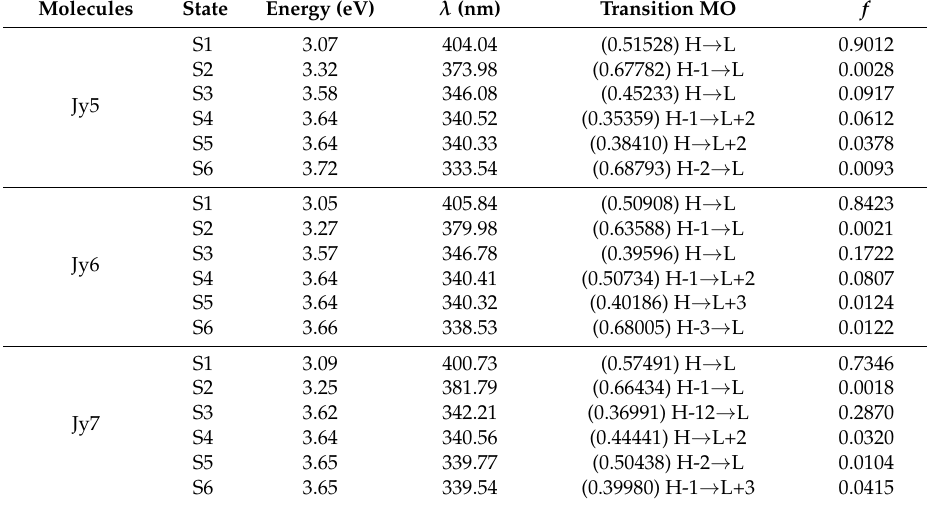
Table 4. Calculated transition energies, absorption peaks λ , major transition molecular orbitals and oscillator strength f of three experimental molecules Jy5–Jy7.